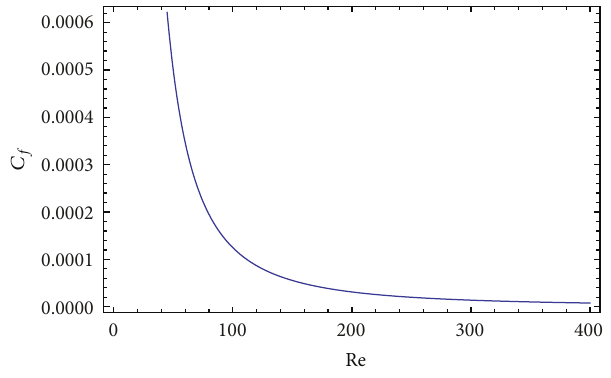
Figure 15: Variation of skin friction versus Reynolds